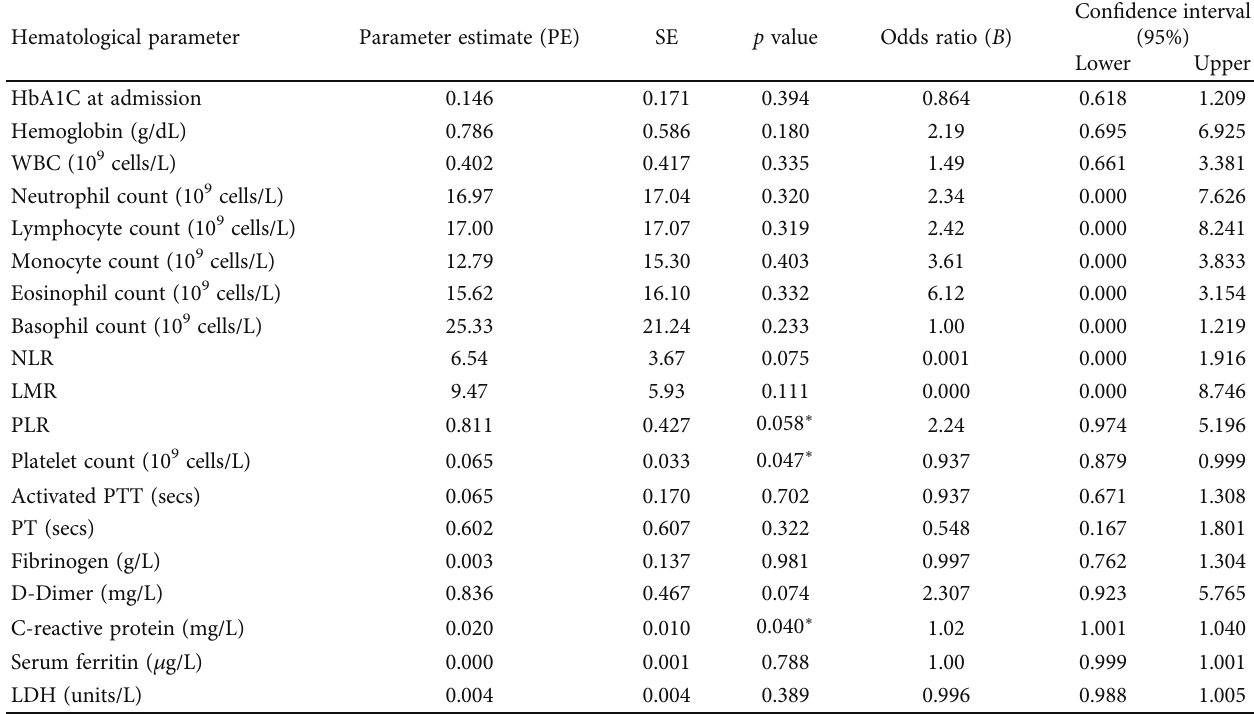
Table 5: Logistic regression analysis to know the impact of lab parameters on COVID-19